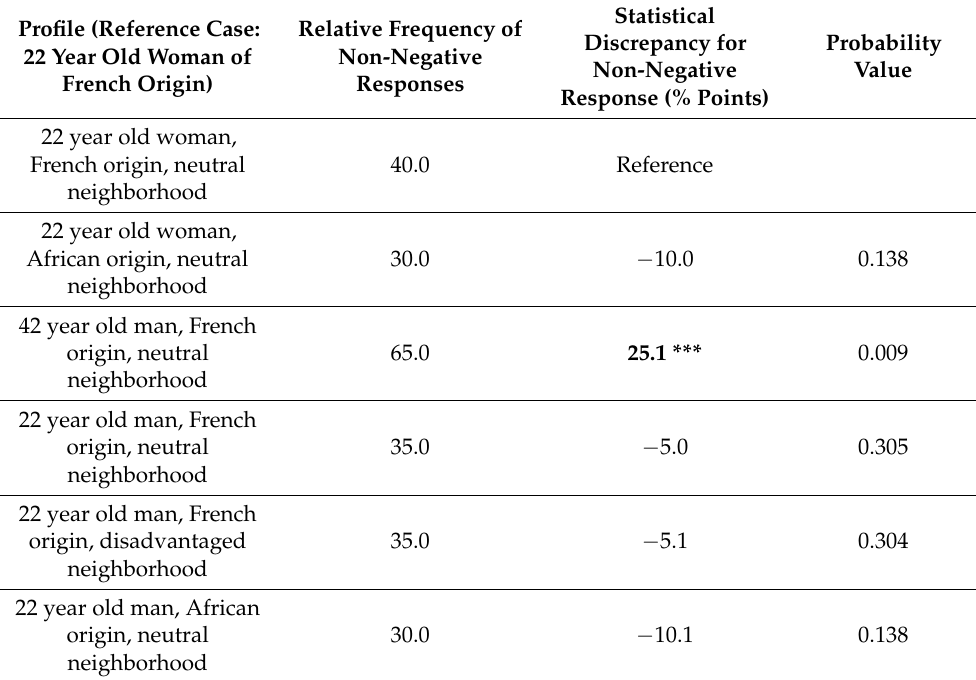
Table 4. Differences in the non-negative response rate relating to loan applications (reference profile: 22 year old woman, French